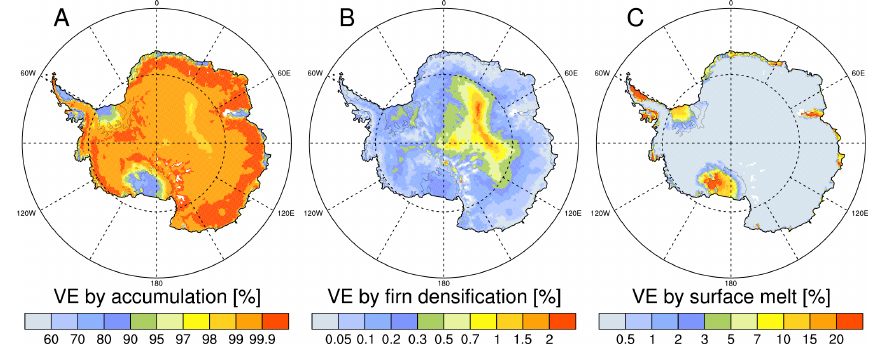
Figure 6. Fraction of firn air content variations (Fig. 5a) explained (VE) by accumulation (a) , firn densification (b) and surface melt (c) . Note the different scales in (a) , (b) , and (c) .